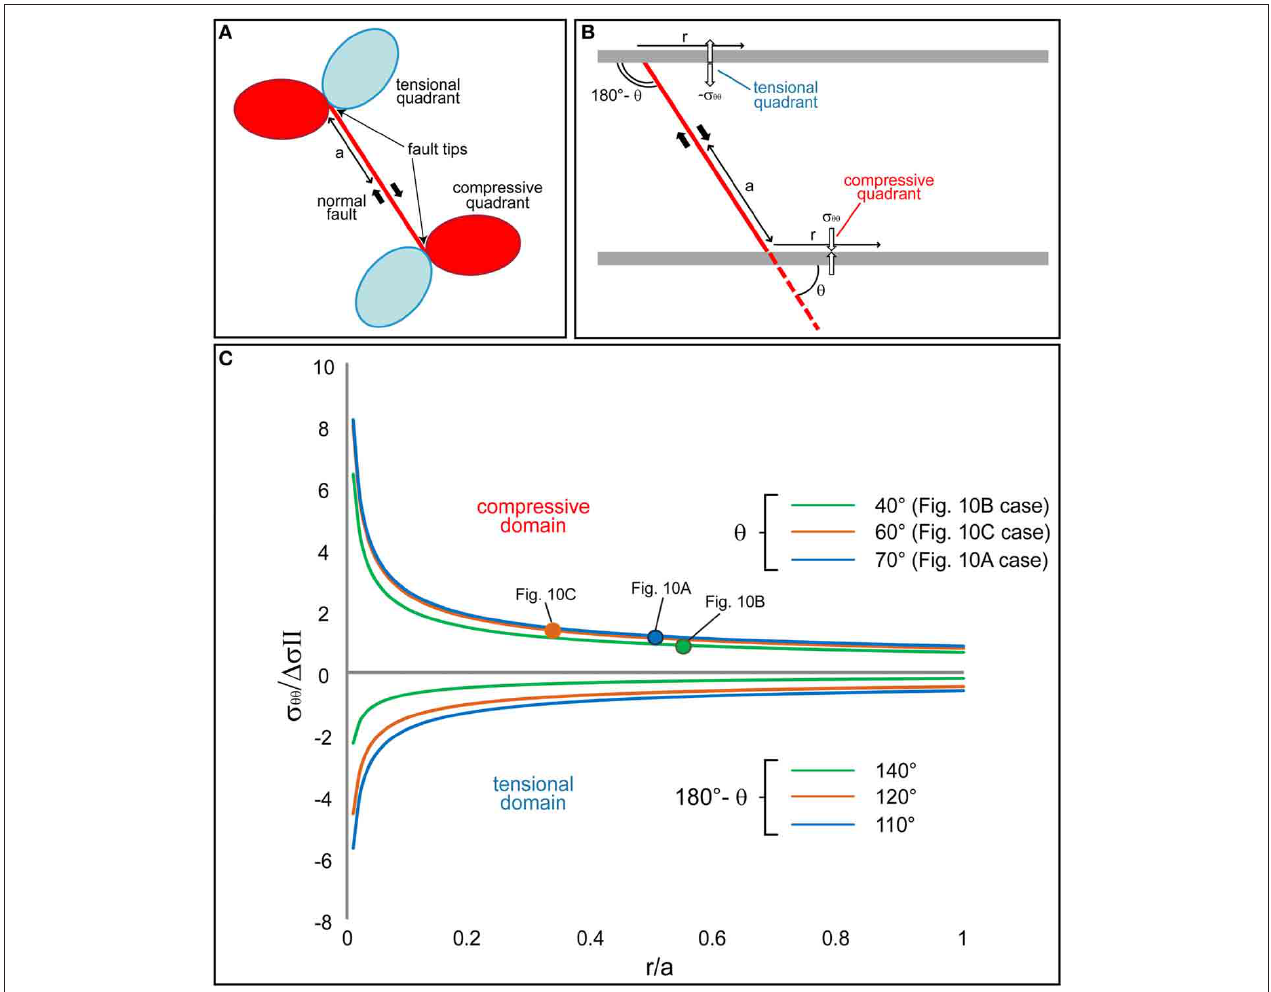
FIGURE 11 | (A) Perturbed stress quadrants (two compressional and two tensional) near the tips of a propagating normal fault (Pollard and Segall, 1987). (B) The fault is approximated with a mode II fracture (i.e., where slip and shear fracture propagation are parallel) in a cylindrical coordinates ( r, θ ) reference system to solve for the circumferential stress in proximity to the fault tip. r is the radial distance from the fault tip of any point on a geological feature of interest, θ the angle from the fault plane, and a the half length of the fault. The circumferential stress ( σ θθ ) will act on the pre-existing discontinuity (stylolite or bedding plane) near the fault tip in a way to affect the amount of pressure solution (on the discontinuity itself). (C) This diagram shows the circumferential stress normalized by the driving stress ( σ θθ /(cid:3) σ II ) as a function of r/a in the compressional (ordinate positive values) and tensional (ordinate negative values) quadrants. θ values larger than 90 ◦ represent the circumferential stress on the sub-horizontal discontinuities in the tensional quadrant, whereas θ values smaller than 90 ◦ represent the circumferential stress on the sub-horizontal discontinuities in the compressional quadrant. Also the r/a values beyond which there is no more tapering of the strata in Figure 10 are reported as colored dots on the plot. Along the horizontal axis, beyond these dots, there is no significant effect of the fault tip stress concentrations on pressure solution on the sub-horizontal